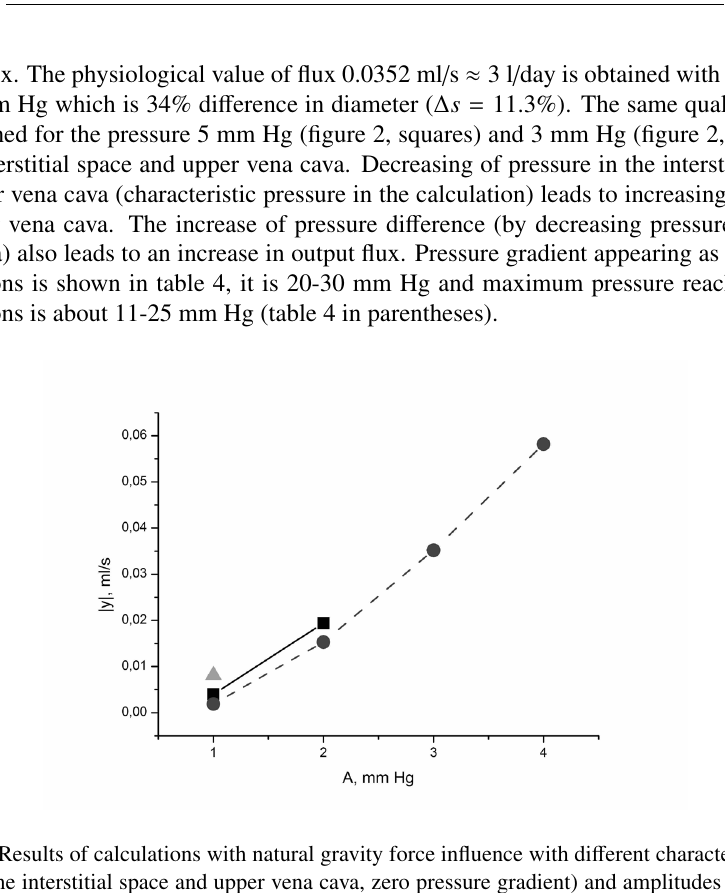
y — average integral flux to the upper vena cava; squares — | |